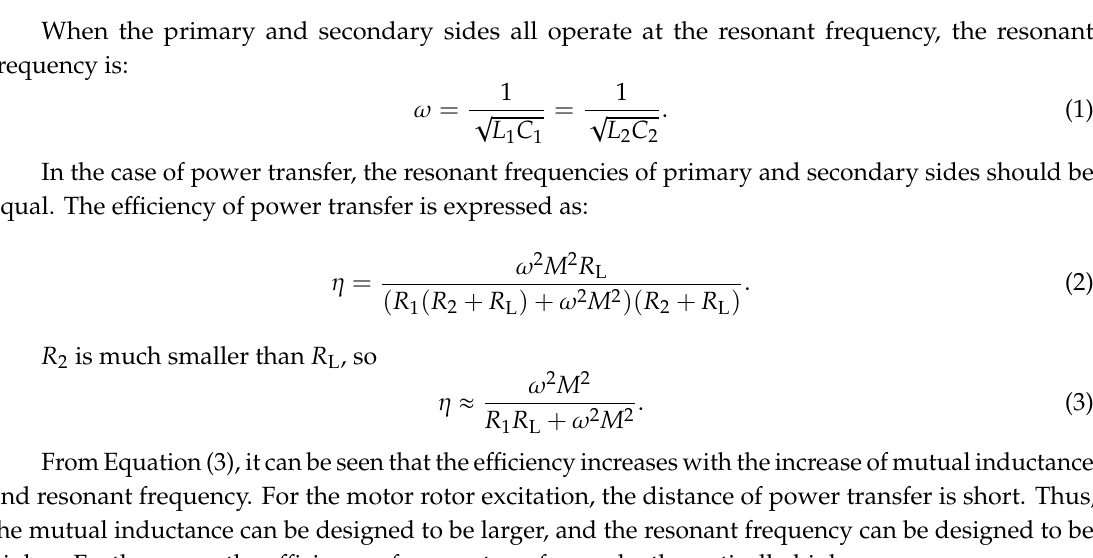
Figure 1. Principle of magnetic resonance coupling wireless power transfer (MRC-WPT).